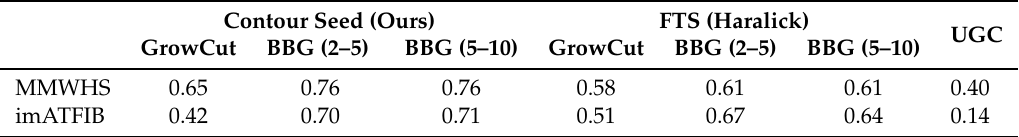
Figure 6. Sample segmentations of MMWHS images. From left to right: image with feature- and texture-based seeding (FTS) (Haralick) seed superimposed (red: foreground, cyan: background), image with contour-based seed superimposed, GrowCut segmentation using FTS (Haralick) seed, GrowCut segmentation using contour-based seed, band-based GrowCut (2–5) segmentation using FTS (Haralick) seed, band-based GrowCut (2–5) segmentation using contour seed, ground truth. Table 4. Median Dice coefficient values obtained using our method, FTS, and unsupervised GrowCut